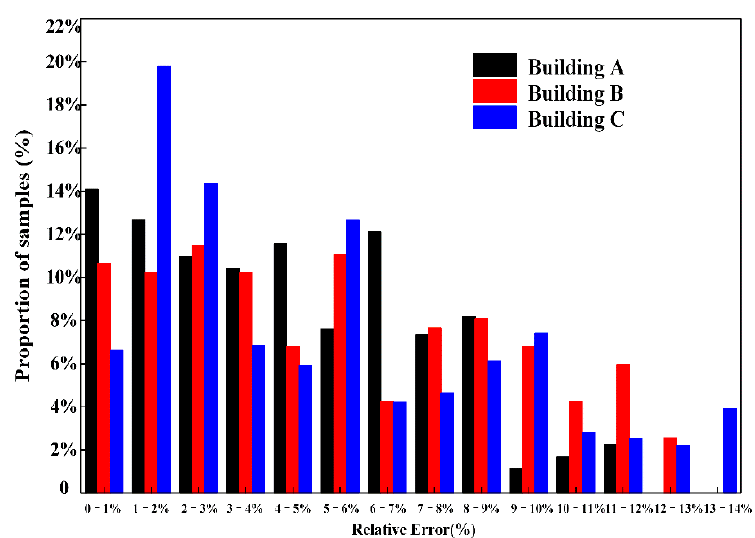
Figure 17. Distribution of the relative error between the separation data and the actual values. At present, there is no accurate specification for energy consumption data processing, but there are clear specifications in the related field of energy consumption prediction, as shown in Table 7 [35,36]. From the strictest point of view, the error of this method is within the acceptable range.